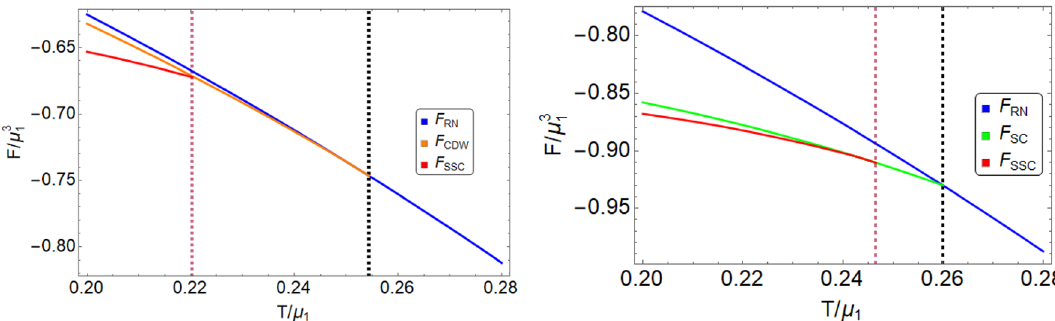
Figure 18 . The averaged free energy for RN black hole, CDW/SC black hole and SSC black hole with x = 1 . 4 (left) and x = 1 . 6 (right),